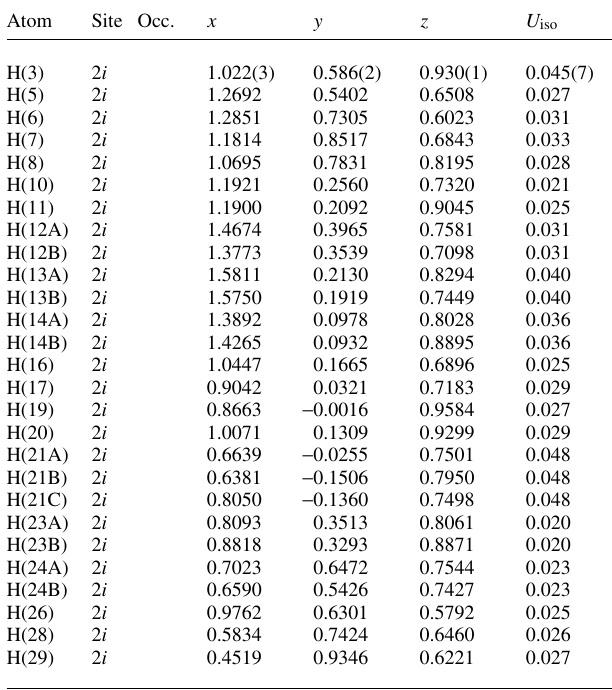
Table 2. Atomic coordinates and displacement parameters (in Å 2 )